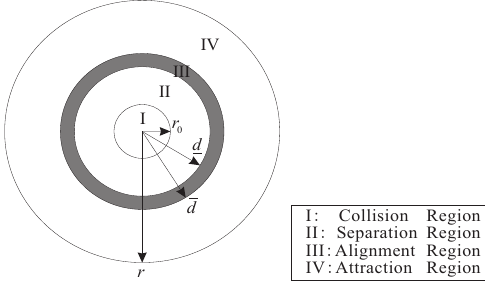
Figure 1. The neighboring set of agent i